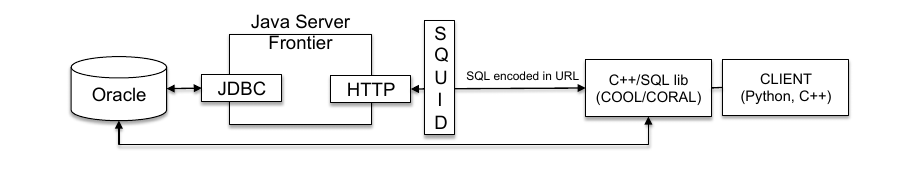
Figure 1. Schematic of the COOL access mechanism